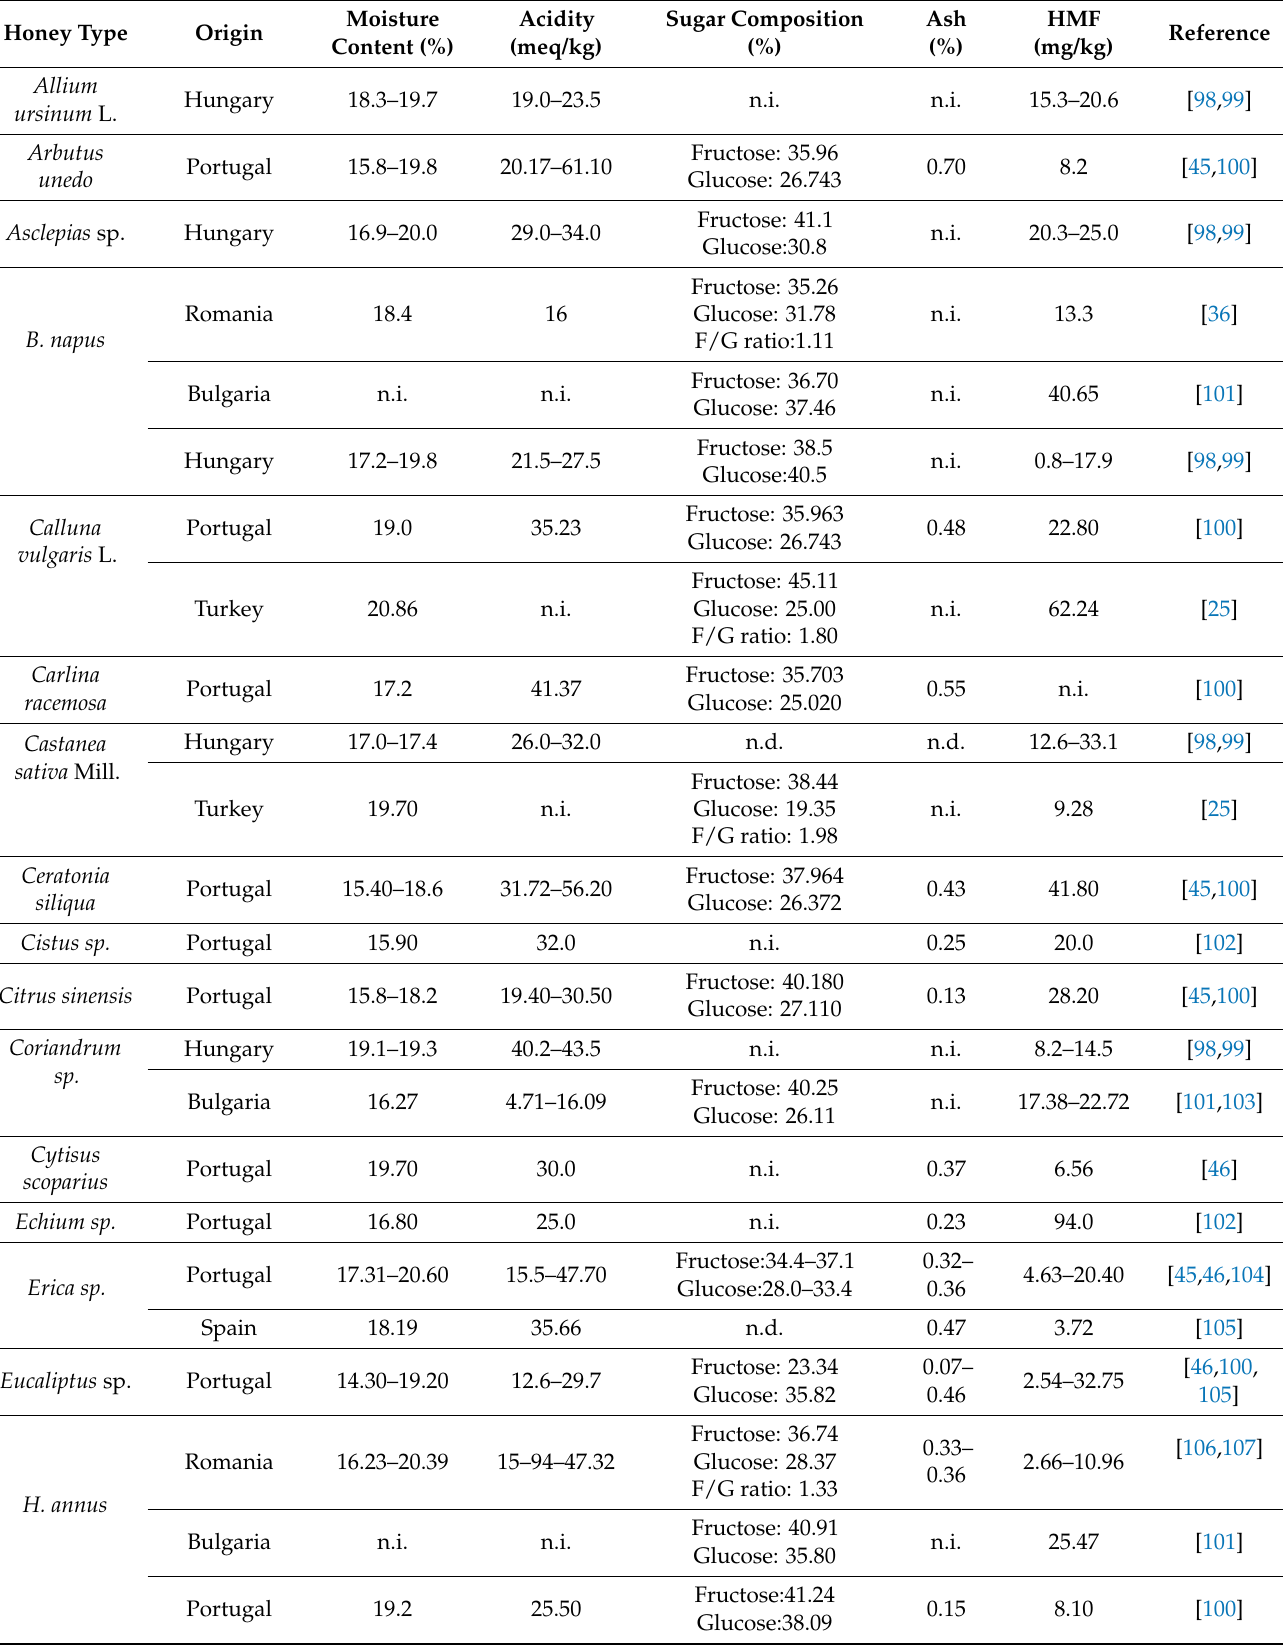
Table 3. Physicochemical properties of monofloral honeys from different geographical